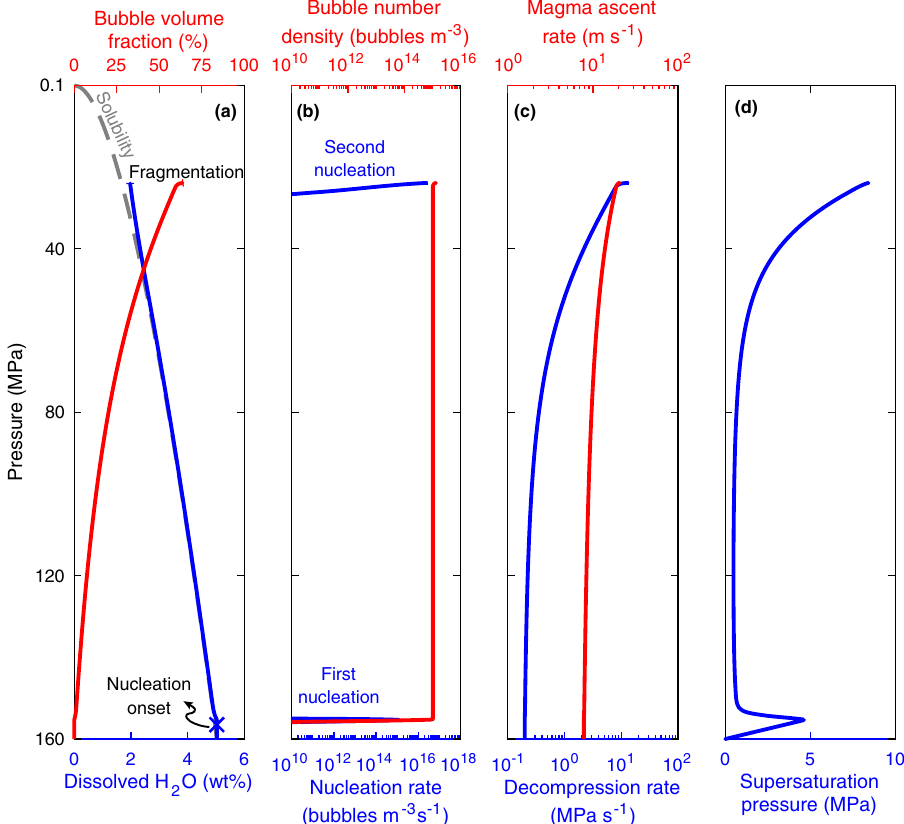
Fig. 4 Illustrative model results of the feedback between water exsolution, decompression rate, and magma fragmentation during heterogeneous nucleation. The contact angle is θ = 160° ( α = 0.003). Nucleation fi rst occurs at low supersaturation. Subsequently H 2 O concentration remains close to equilibrium because of H 2 O diffusion into nucleated bubbles. This results in a progressive increase in viscosity and hence decompression rate. Supersaturation pressure increases gradually, leading to a second nucleation peak, followed by magma